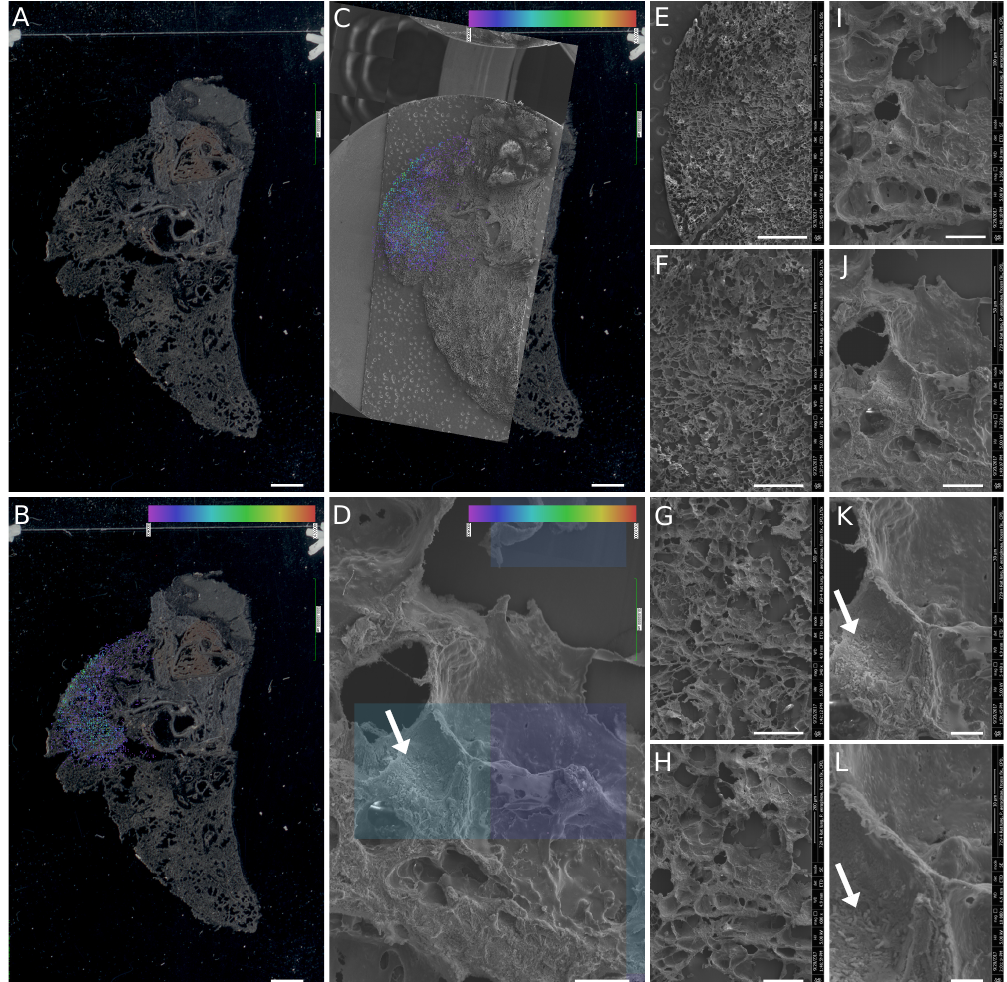
Figure 4. The fusion of MALDI-MSI and SEM imaging of rat lung tissue infected with P. aeruginosa : ( A ) optical scan of the ITO glass slide with the vacuum-dried section; ( B ) optical scan image with MALDI-MSI pyoverdine molecular map in the overlay; ( C , B ) fusion with the SEM navigation image; and ( D ) zoomed-in part of the fused images showing rod-shaped bacteria on the alveolar surface (white arrow, also demonstrated in ( K , L )). Image fusion was generated from an SEM image ( J ) with a lateral resolution of 100 nm per pixel and a part of the pyoverdine molecular map. The size of the transparent blue squares in the overlay corresponds to the lateral resolution of 50 µm per pixel. ( E – L ) A set of the original SEM images used for detailed characterization of the area with a positive pyoverdine signal. Primary magnifications of the SEM images were: ( E ) 85 × ; ( F ) 170 × ; ( G ) 340 × ; ( H ) 680 × ; ( I ) 1360 × ; ( J ) 2720 × ; ( K ) 5440 × and ( L ) 10,880 × . Scalebars: ( A – C ) 2 mm; ( D ) 20µm; ( E ) 1 mm; ( F ) 500µm; ( G ) 250µm; ( H ) 100µm; ( I ) 50µm; ( J ) 25µm; ( K ) 10µm; and ( L )